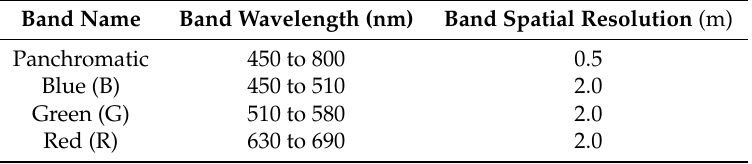
Table 1. Bands name and spectral characteristics (wavelength) from WV-2 sensors.